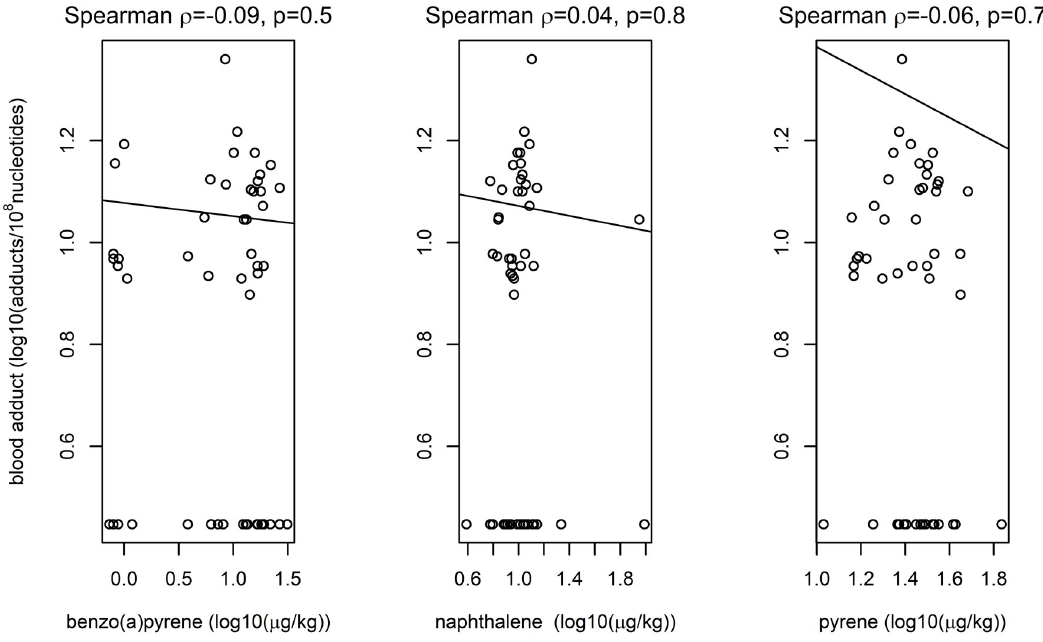
Fig 1. Linear models fit to logarithms of PAHs in moss and their PAH-DNA blood adducts along with rank correlations; non- detects of adducts and benzo[ a ] pyrene were imputed as half of the limit of